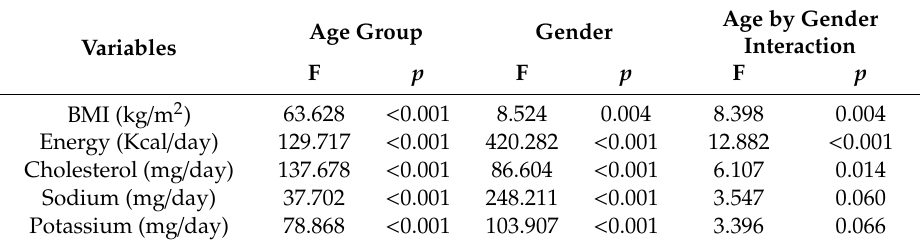
Table 3. Main and interaction e ff ects of gender and age on BMI and dietary intake (N =